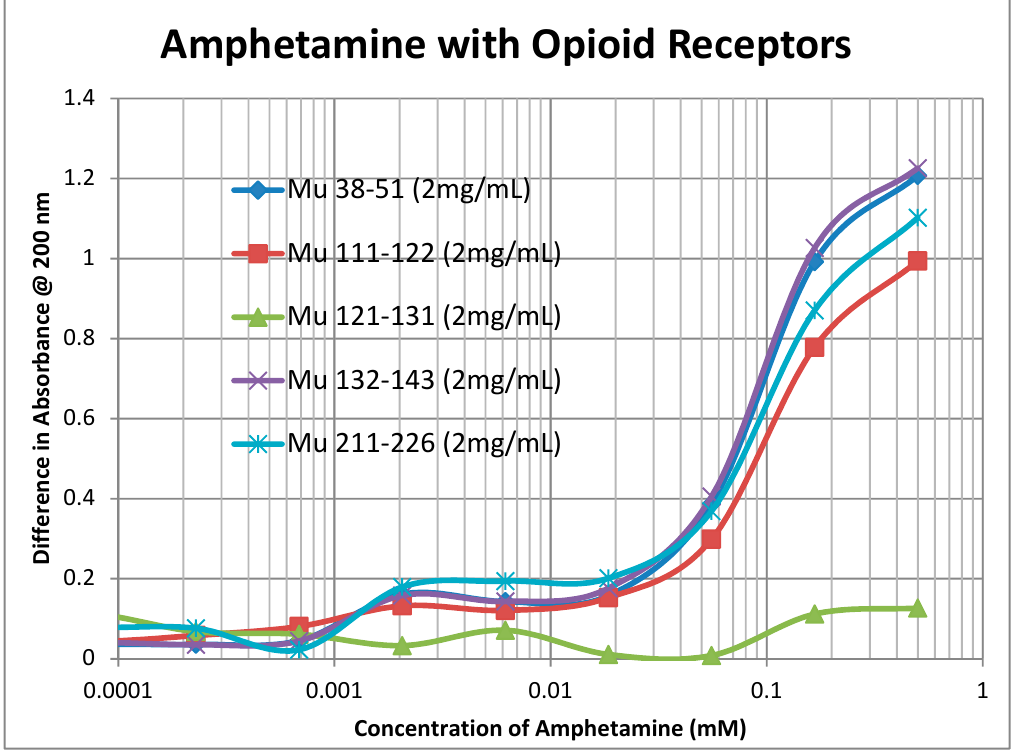
Figure 4. Binding of amphetamine to opioid receptor (muOPR) peptides. Note that there may be both high affinity binding to extracellular receptor peptides Mu 38, Mu 132, Mu 211, and possibly Mu 111, with Kd around 1.3 μ M, and lower affinity binding at around 100 μ M. No binding was observed between amphetamine and the transmembrane peptide Mu 121. Int. J. Mol. Sci. 2019 , 20 , x FOR PEER REVIEW